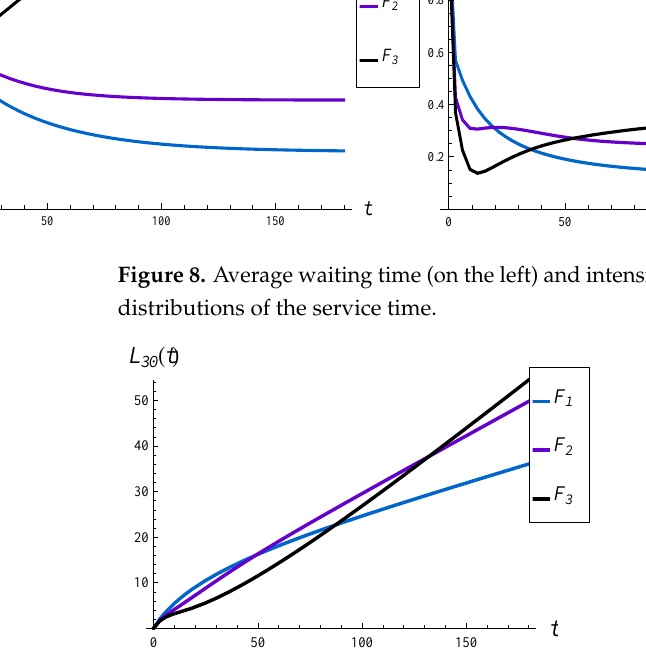
Figure 9. Average number of losses in ( 0, t ) for different distributions of the service